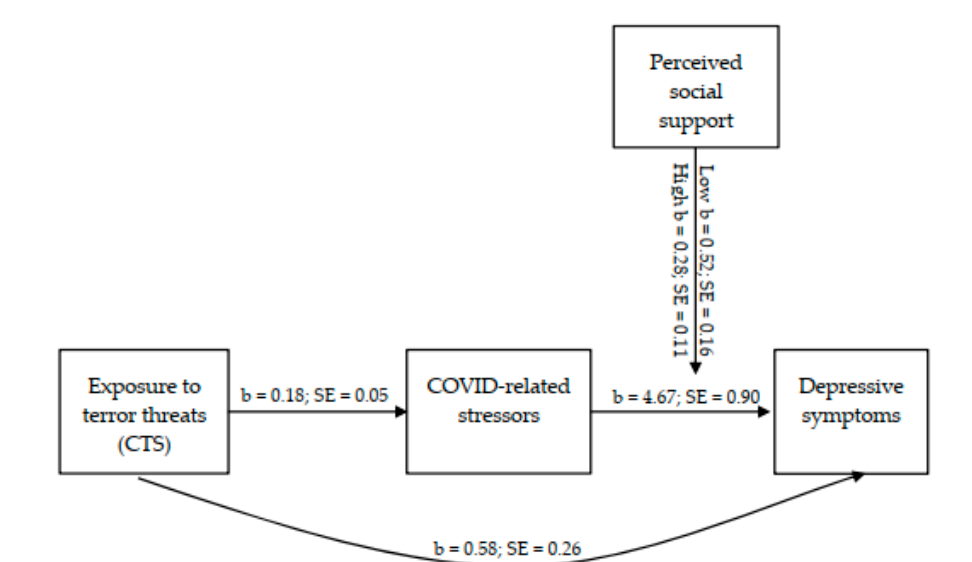
Figure 2. Moderating Effect of Perceived Social Support on the Relations between COVID-Related Concerns and Depression Symptoms.